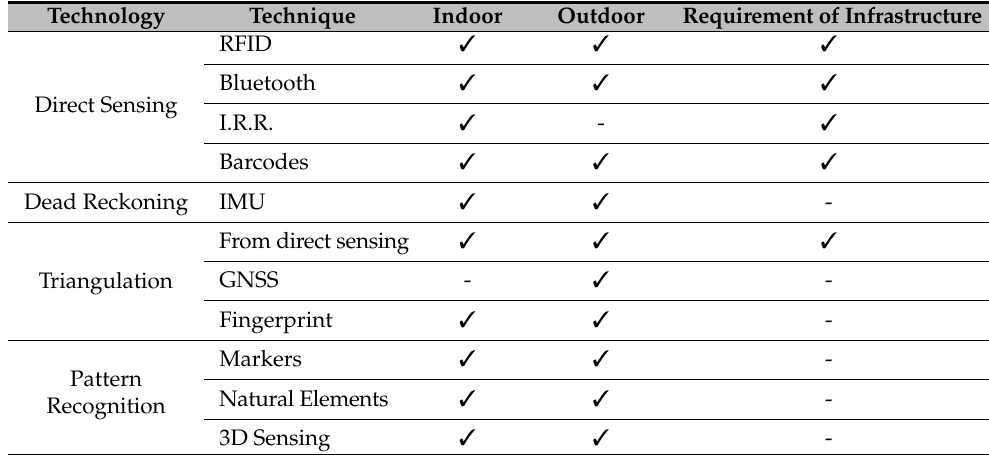
Table 1. Comparison of Existing Technologies Based on Different